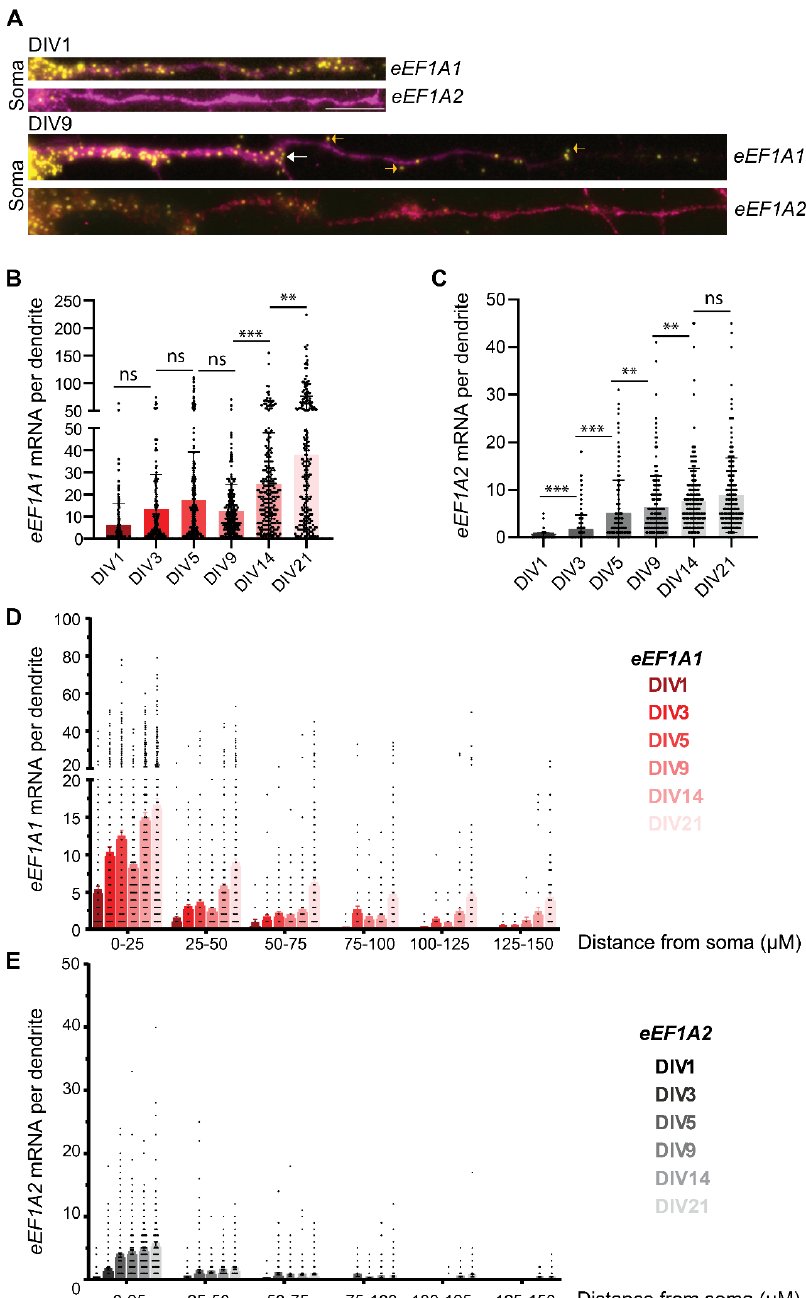
Figure 3. eEF1A1 and eEF1A2 mRNA localization in the dendrites through neurodevelopment. ( A ) smFISH–IF to detect eEF1A1 or eEF1A2 mRNAs in dendrites. Representative smFISH-IF at the indicated DIVs. eEF1A1 and eEF1A2 smFISH colored in yellow, and dendrites stained by IF to detect Map2 indicated in magenta. Scale bar 5 mM. White arrows indicate mRNAs at the dendritic branching site and yellow arrows point to mRNAs outside the dendritic IF staining. ( B , C ) Number of eEF1A1 ( B ) and eEF1A2 ( C ) mRNAs per dendrite. Number of dendrites, eEF1A1 N = 147–238, eEF1A2 N = 115–241. Statistical analysis to compare a specific DIV with the next developmental time point was conducted with one-way ANOVA ( p -value ns > 0.05, * < 0.05, ** < 0.01, *** <